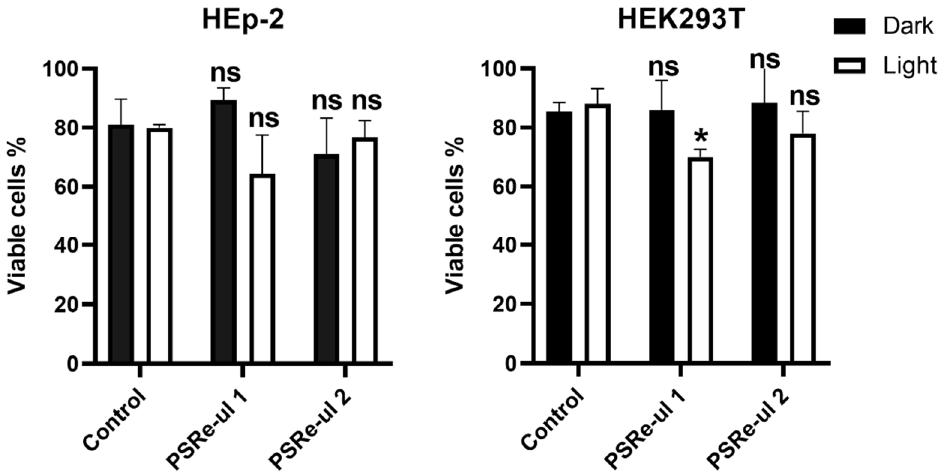
Figure 7. Cytotoxicity of the PSRe-µL1 and PSRe-µL2 compounds. Survival of 5 × 10 5 cells of HEp-2 and HEK293 human cell lines exposed to 4µg/mL of each PSRe-µL1 and PSRe-µL2 compounds were normalized to control untreated cells and expressed as a percentage of dead cells. Dark cytotoxicity was evaluated with cells exposed to the compound but not activated with light. Light-dependent cytotoxicity was evaluated, exposing the cells for 1 h at 17 µW/cm 2 of white LED light. Not significant (ns) p > 0.05, by Student’s t -test between cells exposed to each PS compared to control cells; * p < 0.05 by Student’s t -test cells exposed to each PS compared to control cells.